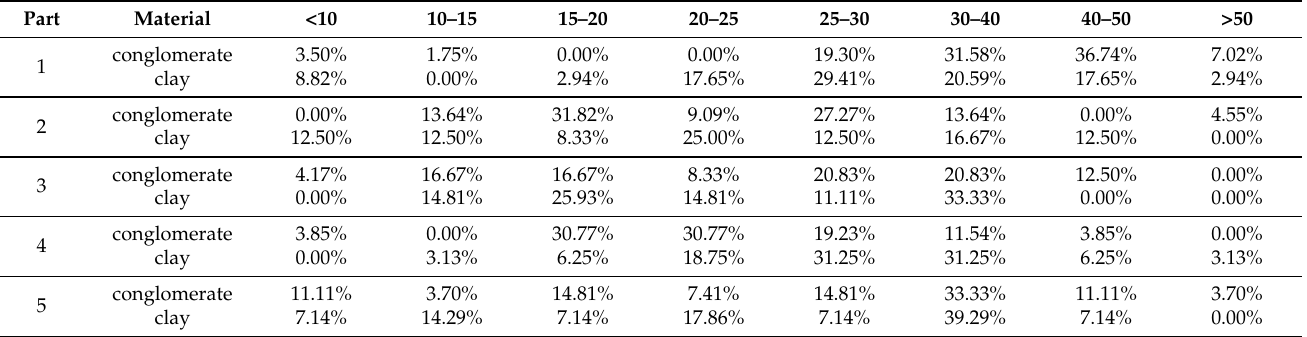
Table 1. Produce a validation set of the material particle size distribution for each of the five samples.